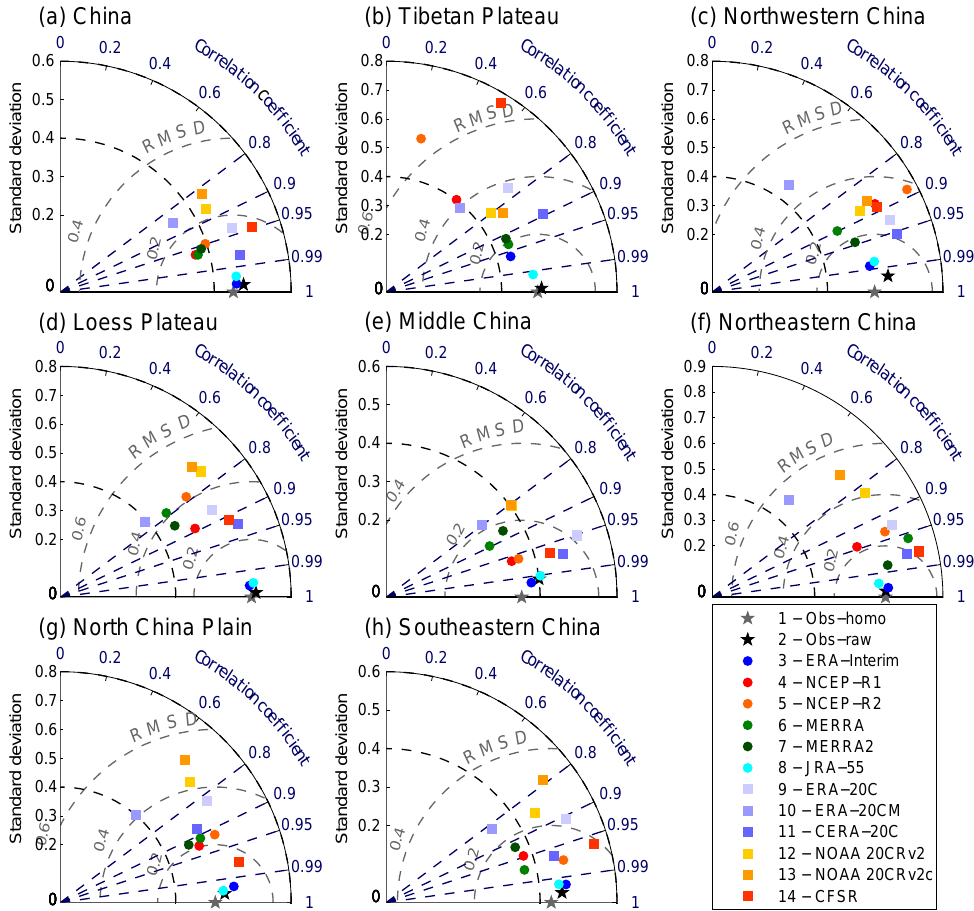
Figure 3. Taylor diagrams for annual time series of the observed and reanalysed surface air temperature anomalies ( T a , unit: ◦ C) from 1979 to 2010 in (a) China and (b–h) the seven subregions. The correlation coefficient, standard deviation and root-mean-squared error (RMSE) are calculated against the observed homogenized T a